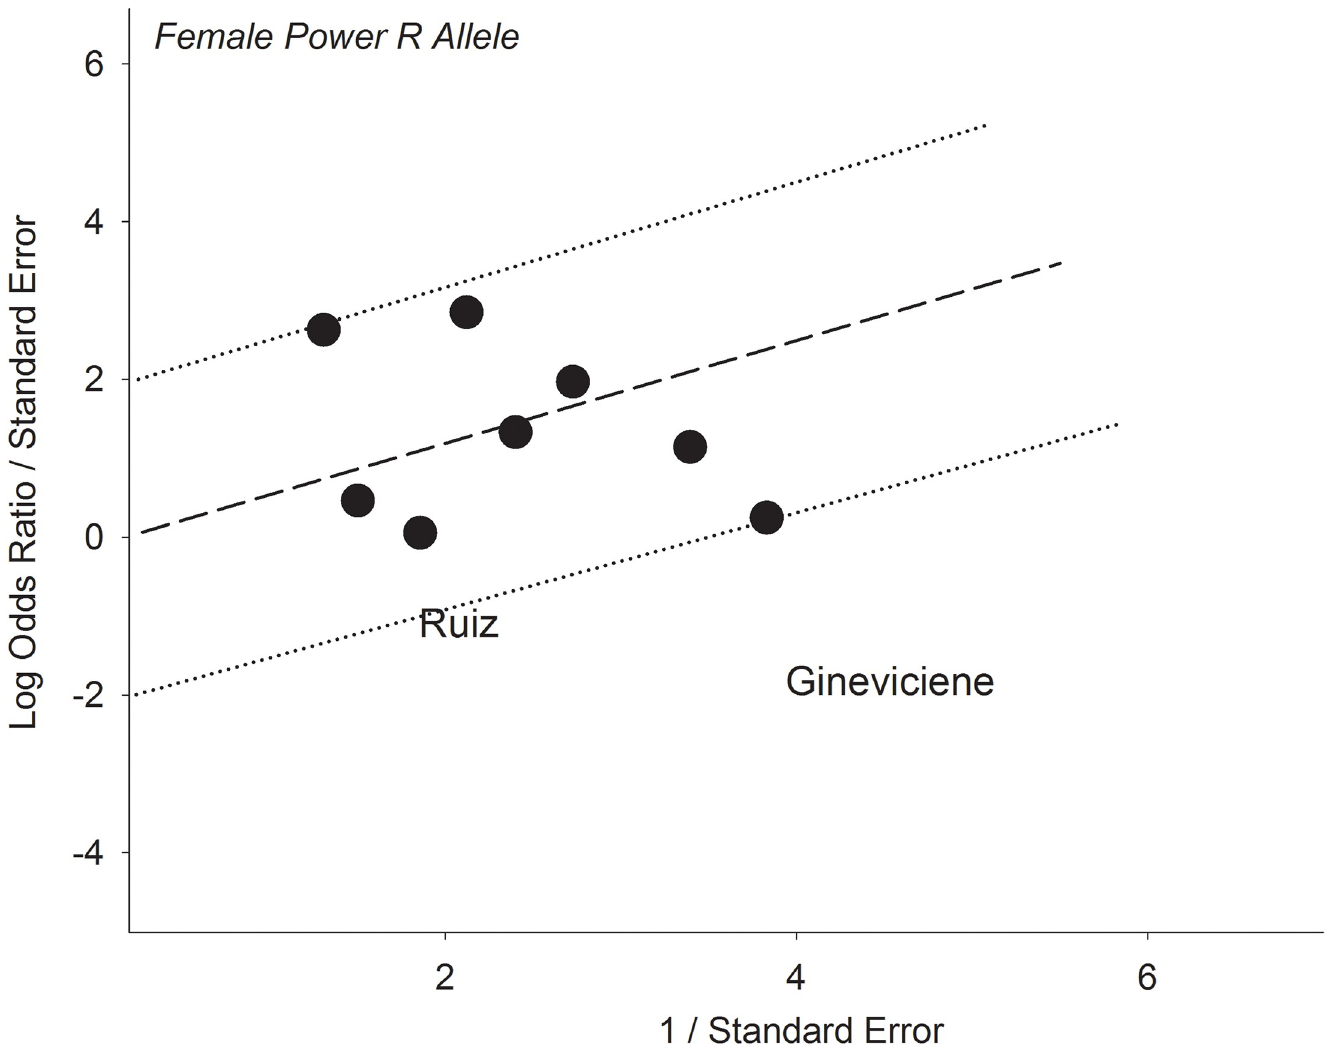
Fig 4. Galbraith plot of the female subgroup in the R allele showing the outlying studies found below the -2 confidence limit. R: wild-type.